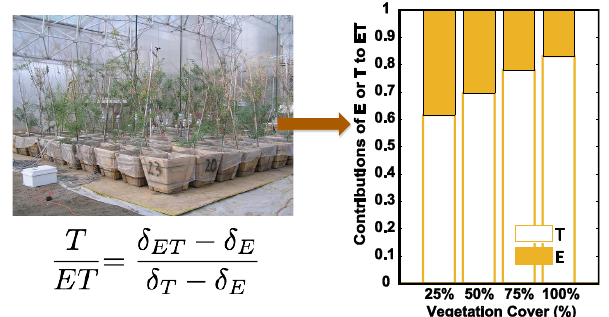
Fig. 5. An example of using laser-based stable isotope monitoring techniques to partition evapotranspiration. The left panel showed the experimental setup inside Biosphere 2 as well as the mass bal- ance equation to calculate the evapotranspiration partition, and the right panel showed the increased transpiration/evapotranspiration ratio as vegetation cover increases, which was modified from Wang et al.